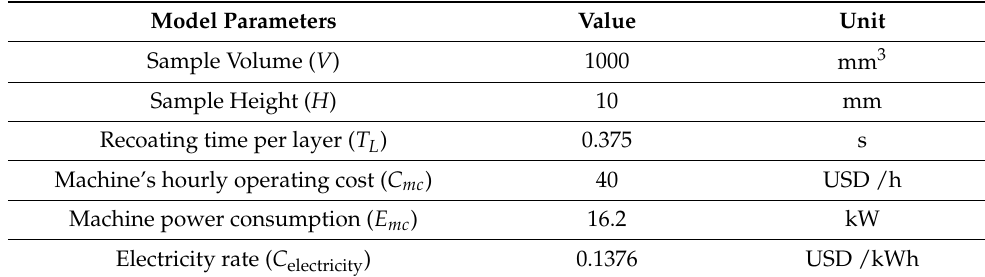
Table 2. Cost model